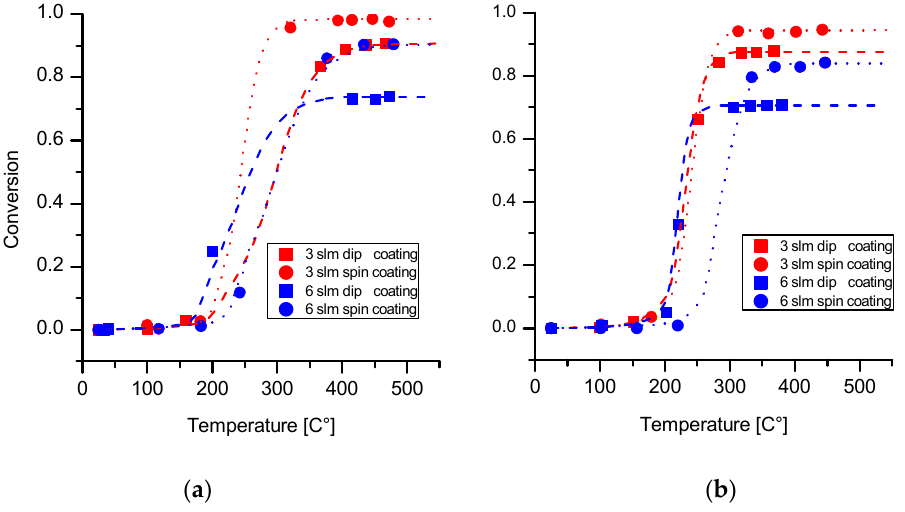
Figure 8. Conversions at 3 and 6 lit · min − 1 for foams prepared with spin coating and dip coating: ( a ) 580 μ m foam; ( b ) 1200 μ m foam.